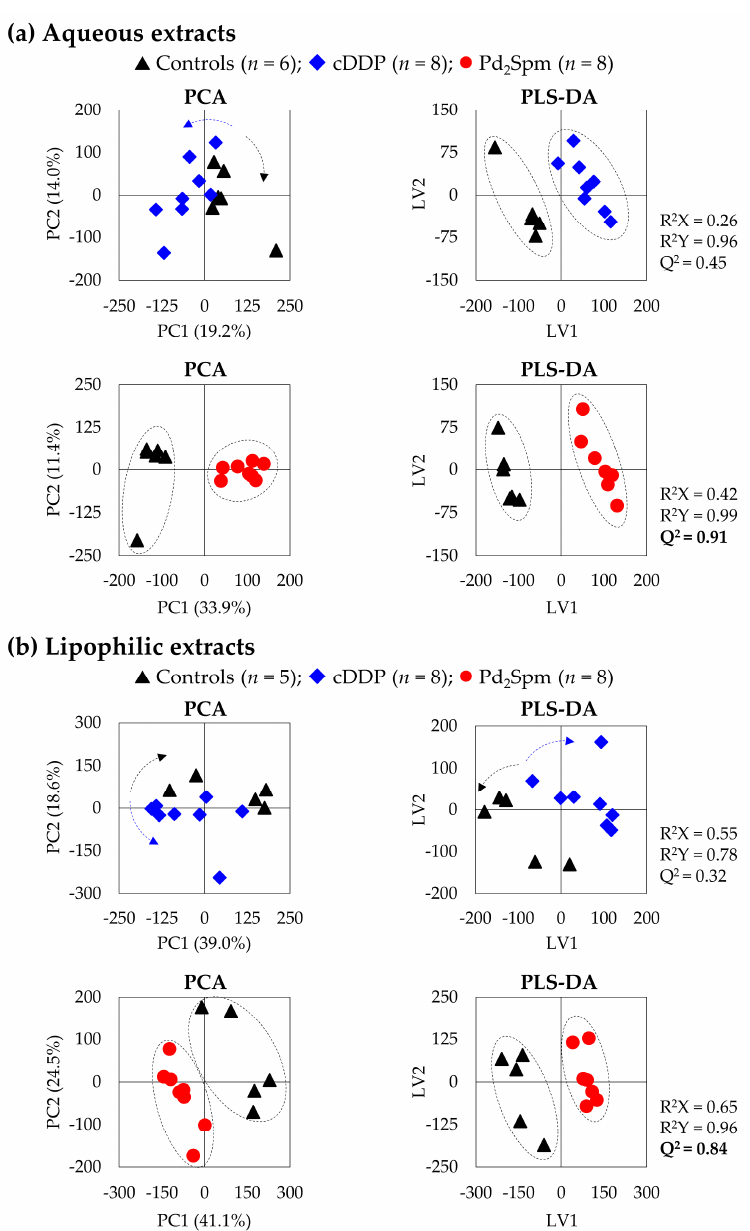
Figure 2. Score scatter plots of PCA (right) and PLS-DA (left) models for 1 H NMR spectra of ( a ) aqueous and ( b ) lipophilic extracts of brain from CDX mice of TNBC, considering the pairwise analysis of the treated groups, with either cDDP or Pd 2 Spm, compared to controls (controls, black triangles, n = 6 or 5 for aqueous or lipophilic extracts, respectively; cDDP-treated, blue diamonds, n = 8; Pd 2 Spm-treated, red circles, n = 8). Validation parameters (R 2 and Q 2 ) are indicated for each PLS-DA model, with Q 2 values > 0.5 highlighted in bold, indicating high predictive power and, thus, robust classes separation.